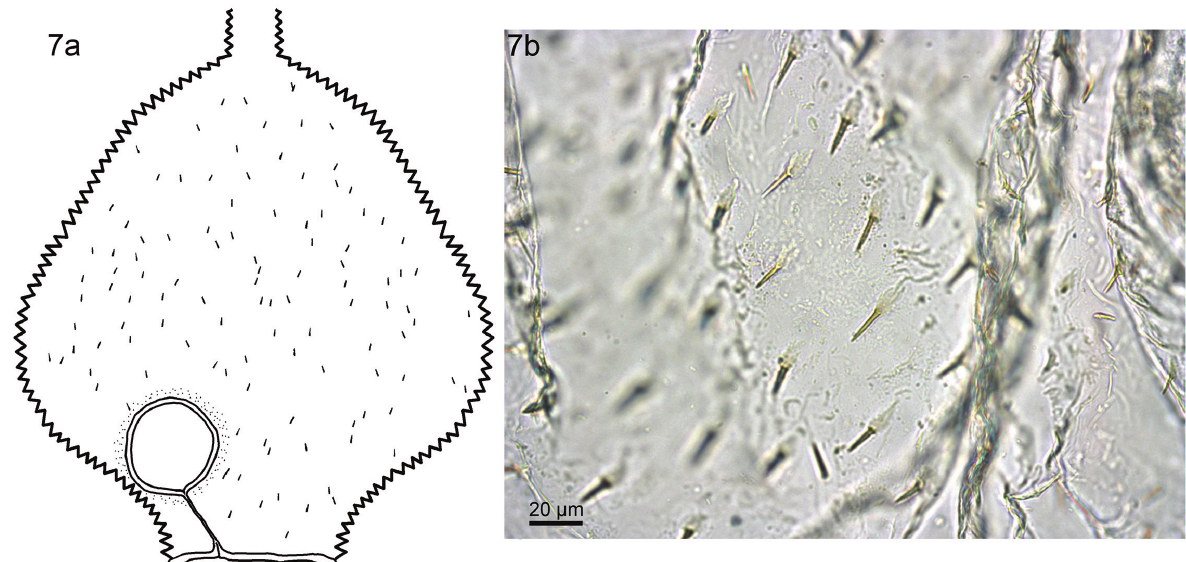
Figure 7. Embiratermes heterotypus . (a) Schematic drawing of P1 showing arrangement of spines; (b) Photomicrograph showing detail of aciculiform spines.